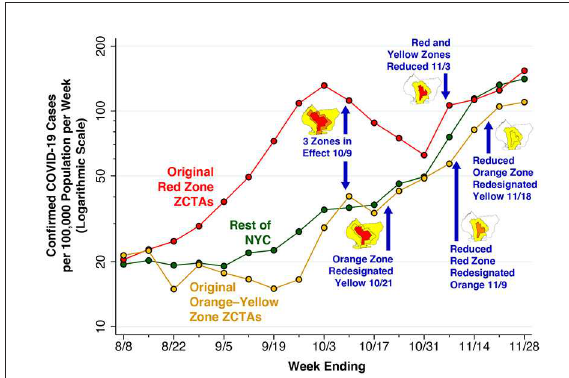
FIGURE4 Confirmed COVID-19 cases per 100,000 population in the original red zone, original combined orange-yellow zones, and the rest of New York City, weeks ending 8/8 through 11/28/2020. The data points represent population-weighted rates, derived from ZCTA-specific weekly COVID-19 incidence as reported by the NYC Department of Health (40), and aggregated according to the scheme in Figure 2A. Superimposed on the graphic are the dates of five successive regulatory actions: (i) establishment of the original three zones on October 9 (7, 29); (ii) re-designation of the original orange zone as yellow on October 21 (24); (iii) reduction in the size of the red and orange zones on November 3 (27, 32); (iv) re-designation of the reduced red zone as orange on November 9 (27); and (v) re-designation of the reduced orange zone as yellow on November 18 (28).